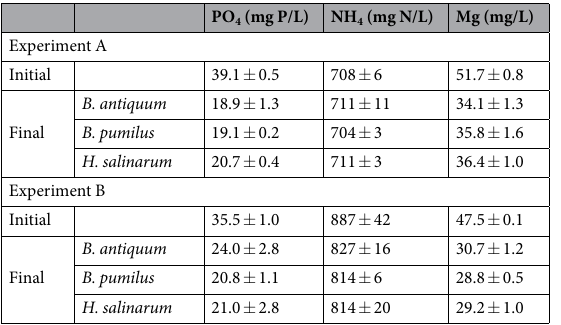
Table 3. Initial and final concentrations of PO 4 , NH 4 , and Mg in sludge dewatering liquors before and after 10 days of incubation with selected bacteria. In Experiment A the pH was controlled through acid addition and in Experiment B the pH controlled by limiting degassing in closed serum